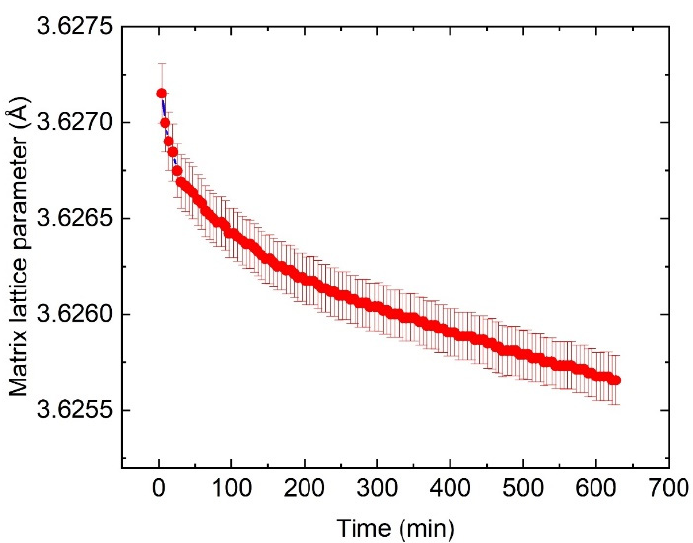
Figure 4. Time dependence of the matrix lattice constant, acquired from the in situ XRD measure- ments at 700 °C. We observed a monotonic decrease in the lattice parameter, indicating that heavy elements such as Nb and Mo gradually diffuse from the solid-solution matrix and contribute to the nucleation and growth of the δ phase. The uncertainty reported in this figure and hereafter represents one standard deviation unless specified otherwise.